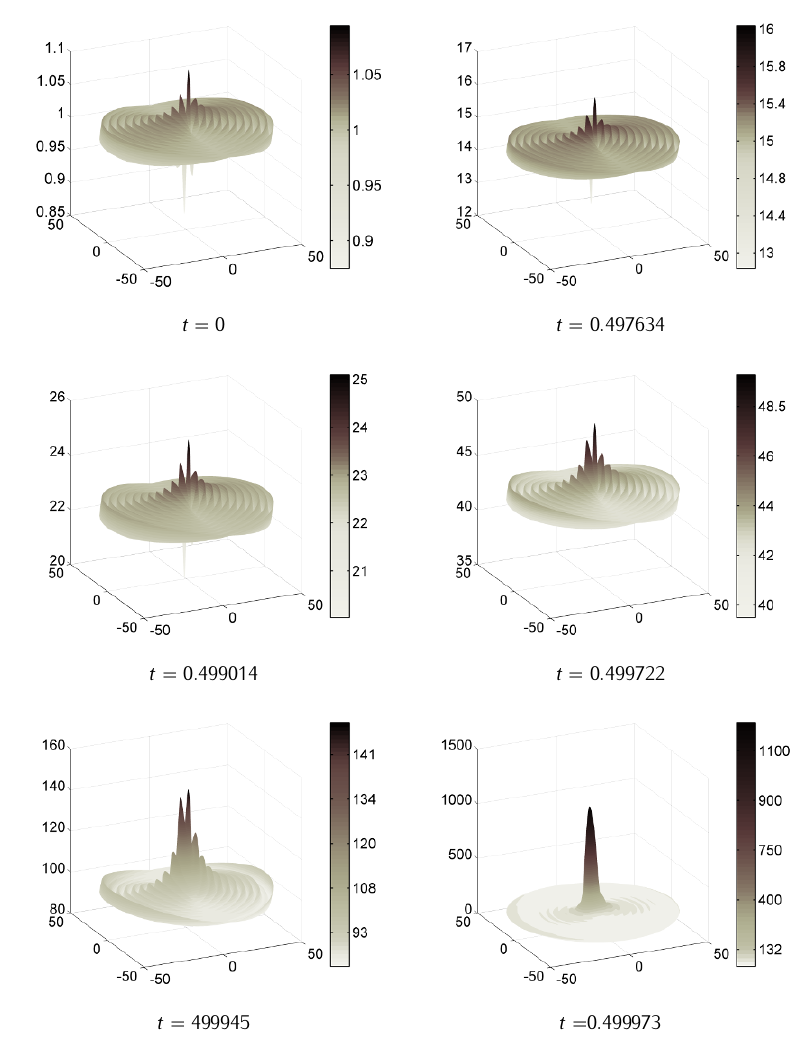
Figure 6. Evolution in time of the self-similar solution u